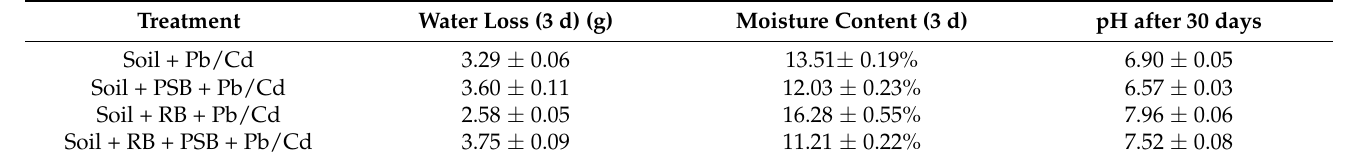
Table 3. The changes of soil water content in a 3-day interval and the soil pH of each